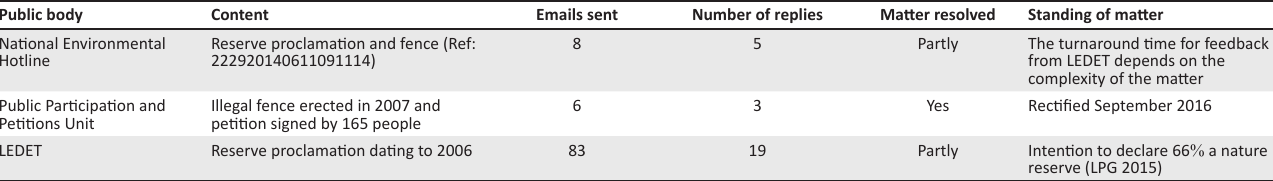
TABLE 2: Follow up of outstanding issues with the National Environmental Crimes and Incidents Hotline, the Limpopo Legislature Public Participation and Petitions Unit and Limpopo Department of Economic Development, Environment and Tourism from June 2014 to September 2016. Public